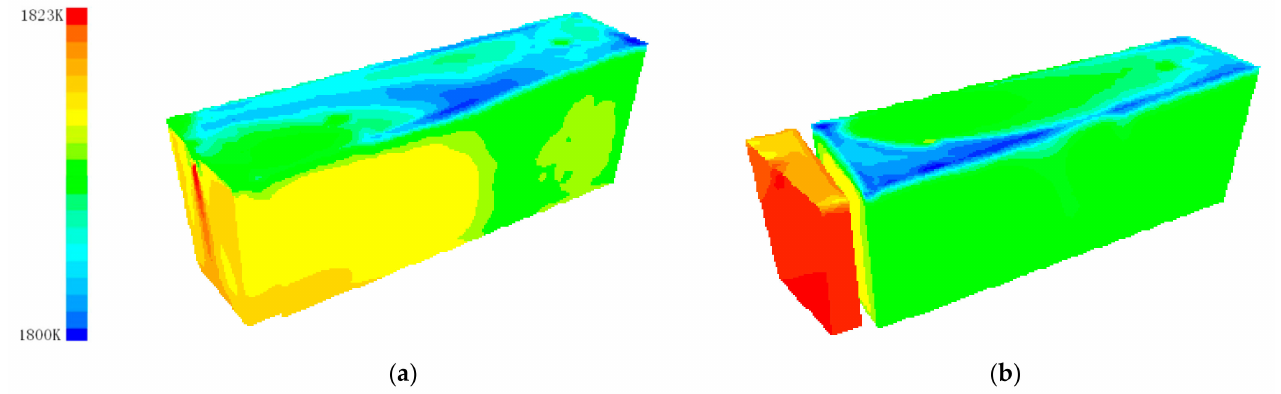
Figure 7. The temperature field according to the numerical simulation. ( a ) Without FCDs; ( b ) with optimized